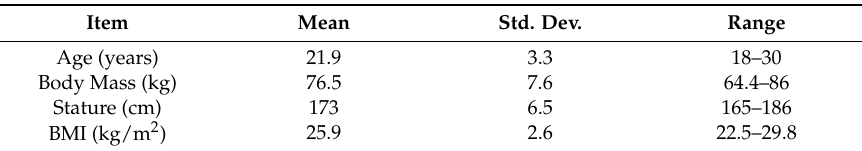
Table 3. Summary information about study participants.